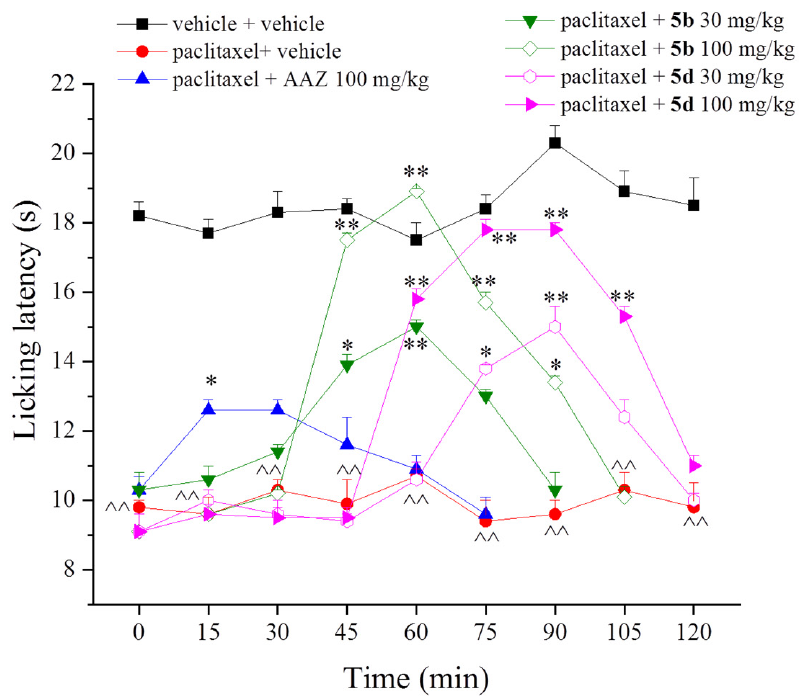
Figure 1. Effect of single CAI treatment on pain behavior induced by paclitaxel. Sensitivity to a non-noxious thermal stimulus was measured by the Cold plate test. Paclitaxel (2.0 mg/kg, i.p.) was administered on four days (1, 3, 5, and 8). On day 10, 5b and 5d were acutely per os administered at doses of 30 mg/kg and 100 mg/kg. AAZ 100 mg kg − 1 was used as a reference compound. Assessment of cold allodynia was performed before and 15, 30, 45, 60, 75, 90, and 120 min after treatments. Results are expressed as the mean ± S.E.M. of eight mice analyzed in two different experimental sets. ˆˆ p < 0.01 vs. vehicle + vehicle; * p < 0.05 and ** p < 0.01 vs. paclitaxel + vehicle. Thereafter, to assess the protective effect of 5b and 5d in the same neuropathic pain model, both compounds were subjected to a repeated treatment at 100 mg/kg over a 15-day period. Molecules were per os daily administered starting the same day of paclitaxel injection until the end of the experiment (day 15). AAZ 100 mg/kg was still used as the reference drug. The response to a thermal non-noxious stimulus (Cold plate test) was measured on days 4, 7, 11, and 15, 24 h after the last treatment. Paclitaxel injections evoked a painful condition that was maximum on day 15 in comparison to the control animals (9.0 ± 0.3 s vs. 18.6 ± 0.4 s, respectively). Both molecules were active after one week of repeated treatment, evoking an anti-allodynic effect when the Cold plate test was performed on day 7 from the beginning of the experiment. On the same day, AAZ was inactive (Figure 2). During the second week of treatment, 5b showed the best protective profile, increasing the mouse licking latency up to 16 s on day 11. The anti-allodynic effect remained stable until the end of the experiment (day 15). 5d exerted a lower antalgic profile in comparison to 5b but was still significant (Figure